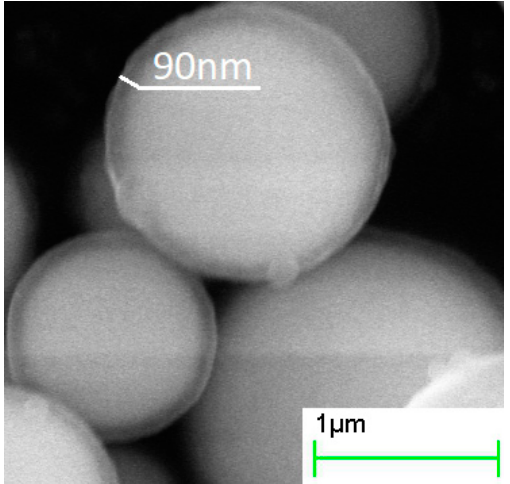
Figure 6. SEM images of core–shell particles obtained in the process with [TEOS]/[NH 3 ·H 2 O] = 4.5 ammonia concentration.